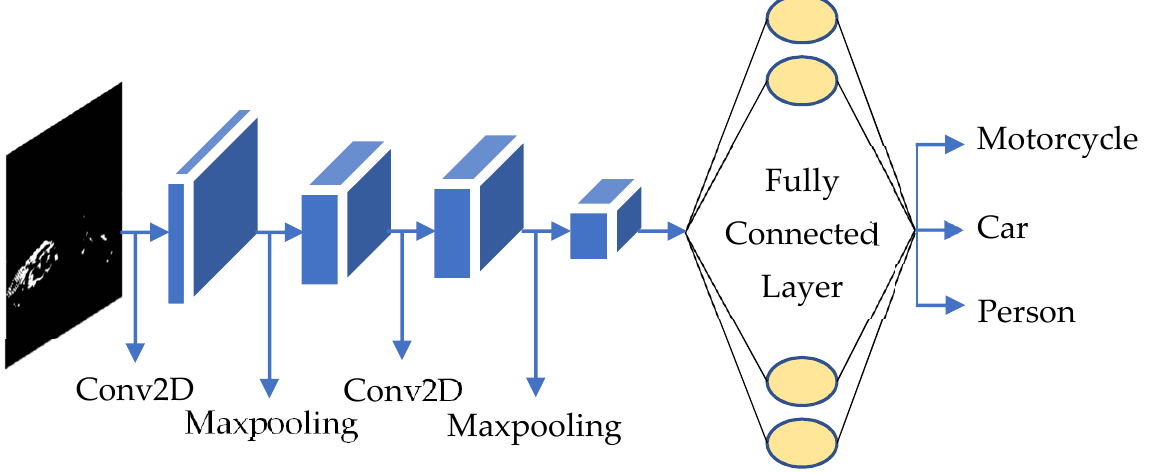
Figure 1. Conventional CNN structure as single input.